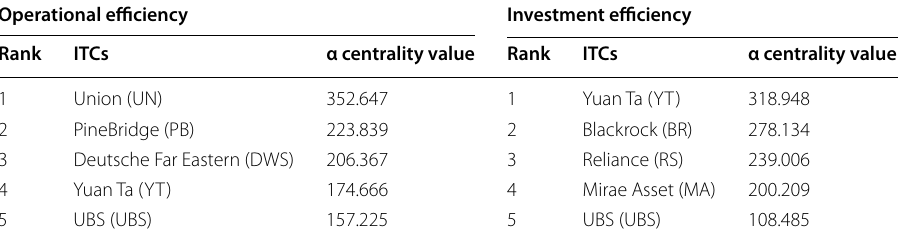
Table 8 Ranks of the efficient ITCs at two‑stage production processes Operational